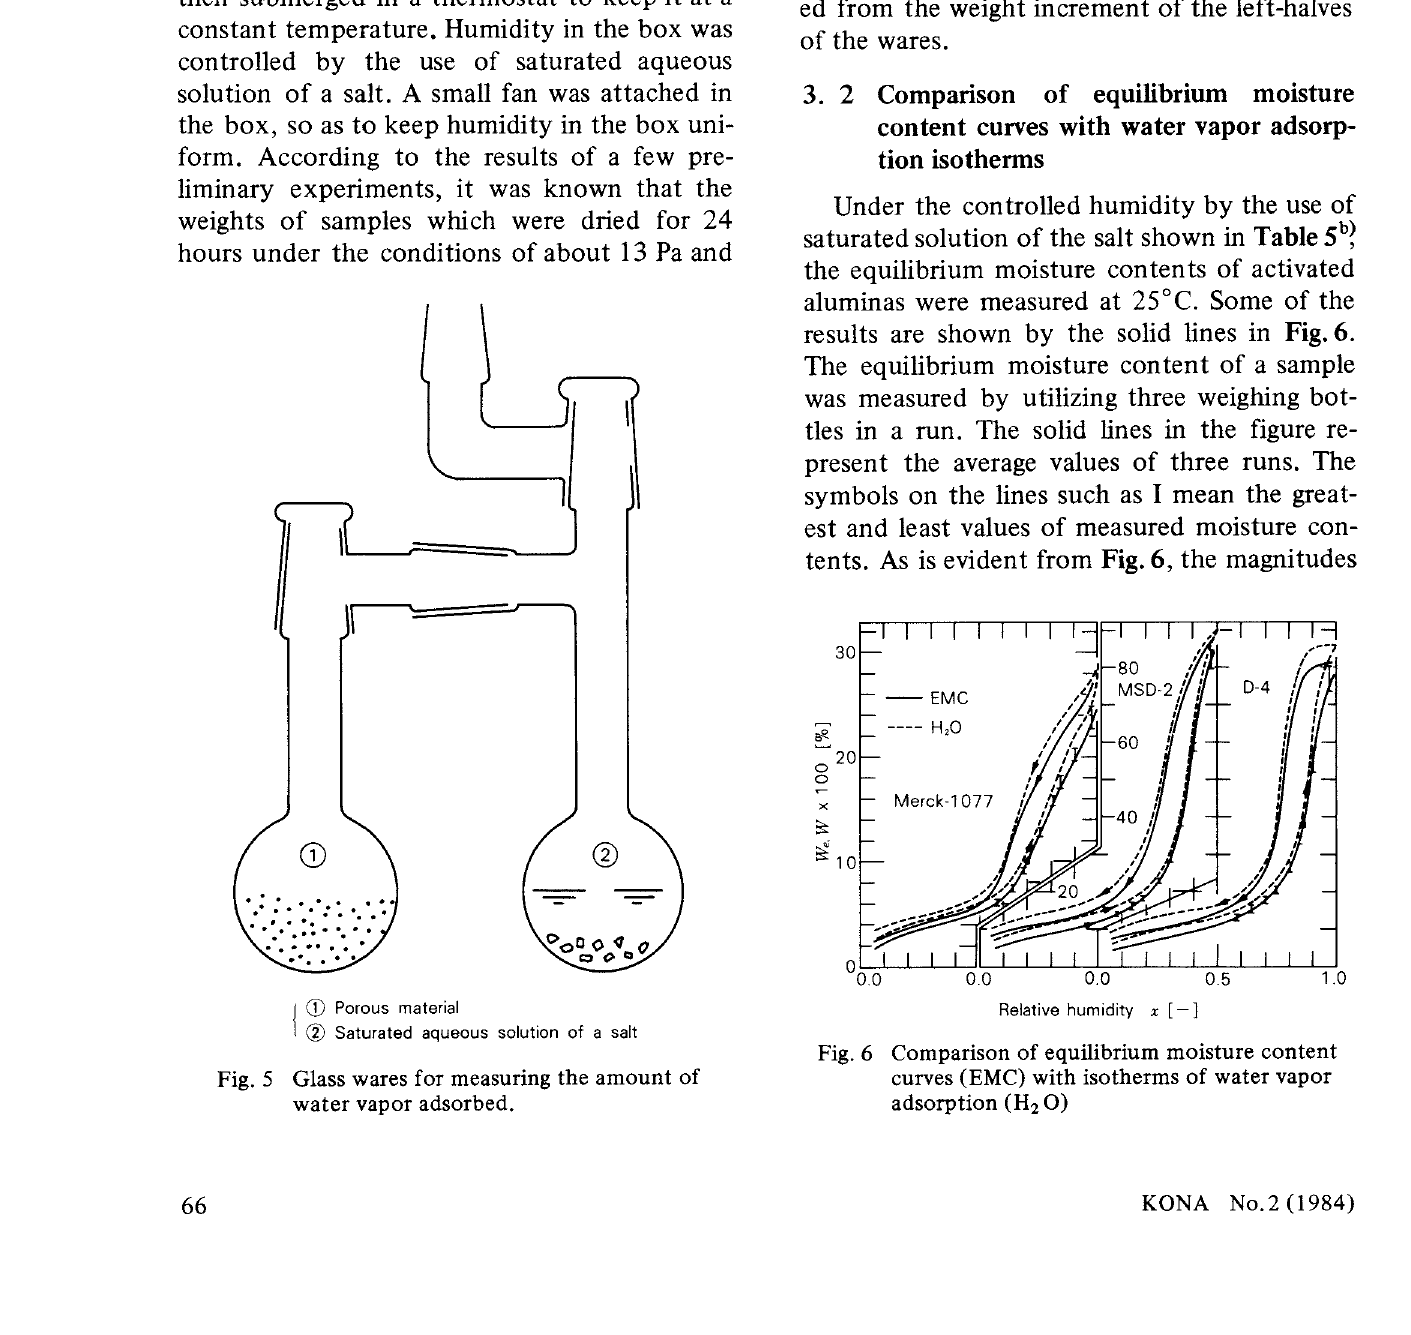
Fig. 5 Glass wares for measuring the amount of water vapor adsorbed.